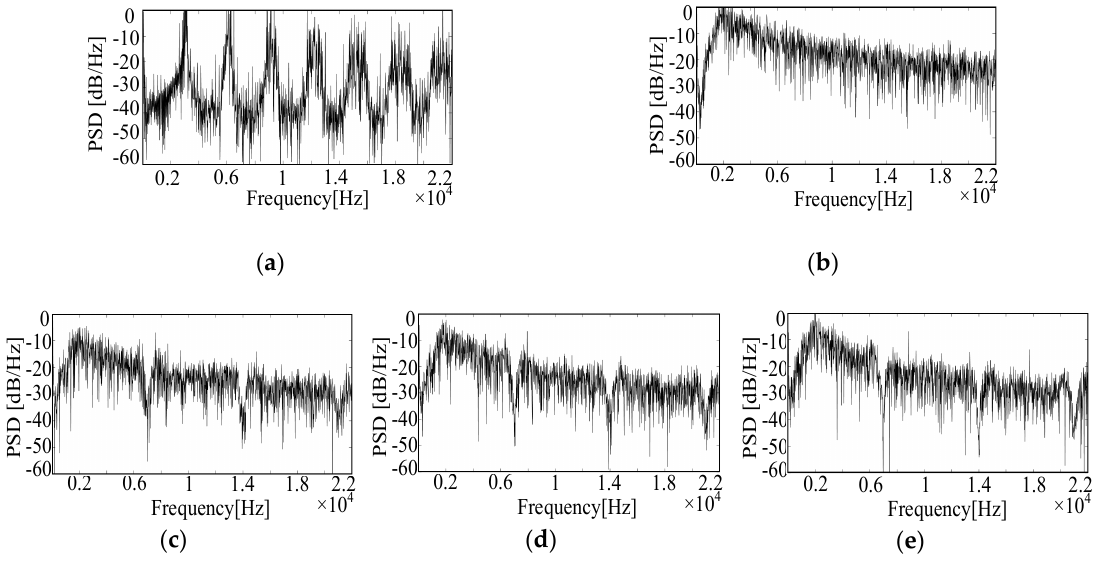
Figure 6. Simulated waveforms of voltage power spectral density (PSD). ( a ) Fixed switching frequency; ( b ) Traditional RPWM; and proposed method when f 0 = 7 kHz ( c ) M = 0.9; ( d ) M = 0.7; ( e ) M = 0.5.